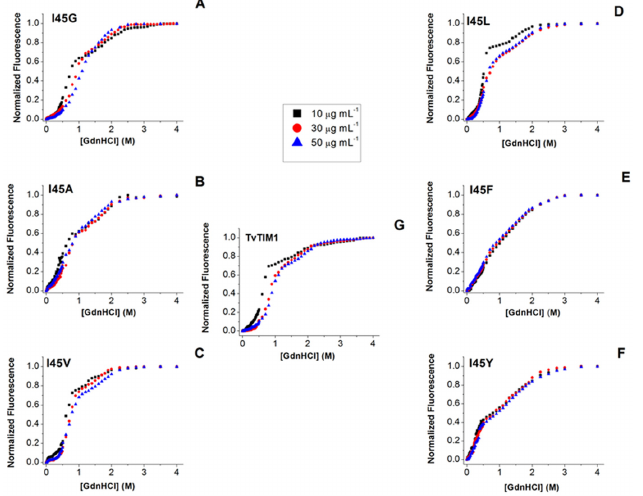
Fig 4. GdnHCl-induced denaturation profiles of TvTIM1 and mutants at residue 45, as measured by intrinsic fluorescence emission. (A) I45G, (B) I45A, (C) I45V, (D) I45L, (E) I45F, (F) I45Y and (G) Wild-type TvTIM1. Protein concentration was 10 (black squares), 30 (red circles) or 50 (blue triangles) μ g mL -1 in 50 mM Tris-HCl pH 7.4 and 10 mM NaCl, at 25°C. Samples were excited at 280 nm and the data have been normalized for ease of comparison.